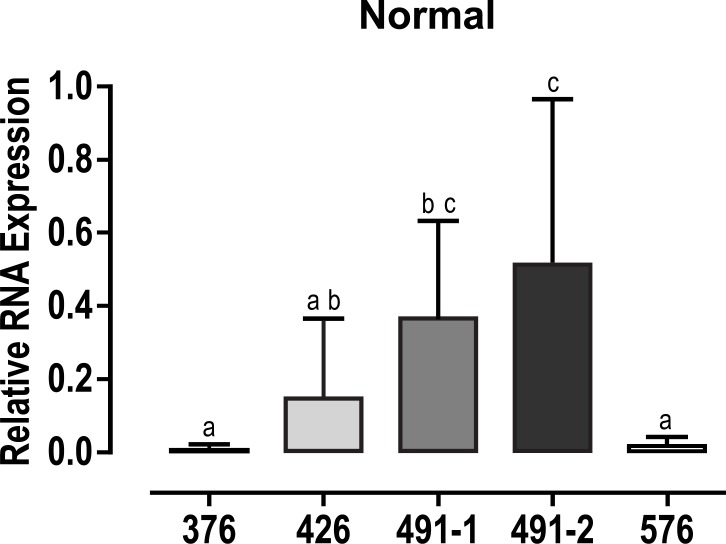
Relative expression of FMR1 gene.FMR1 RNA expression using different set of primers in granulosa cells from women with normal alleles of FMR1. Different characters indicate significant statistical difference between columns.